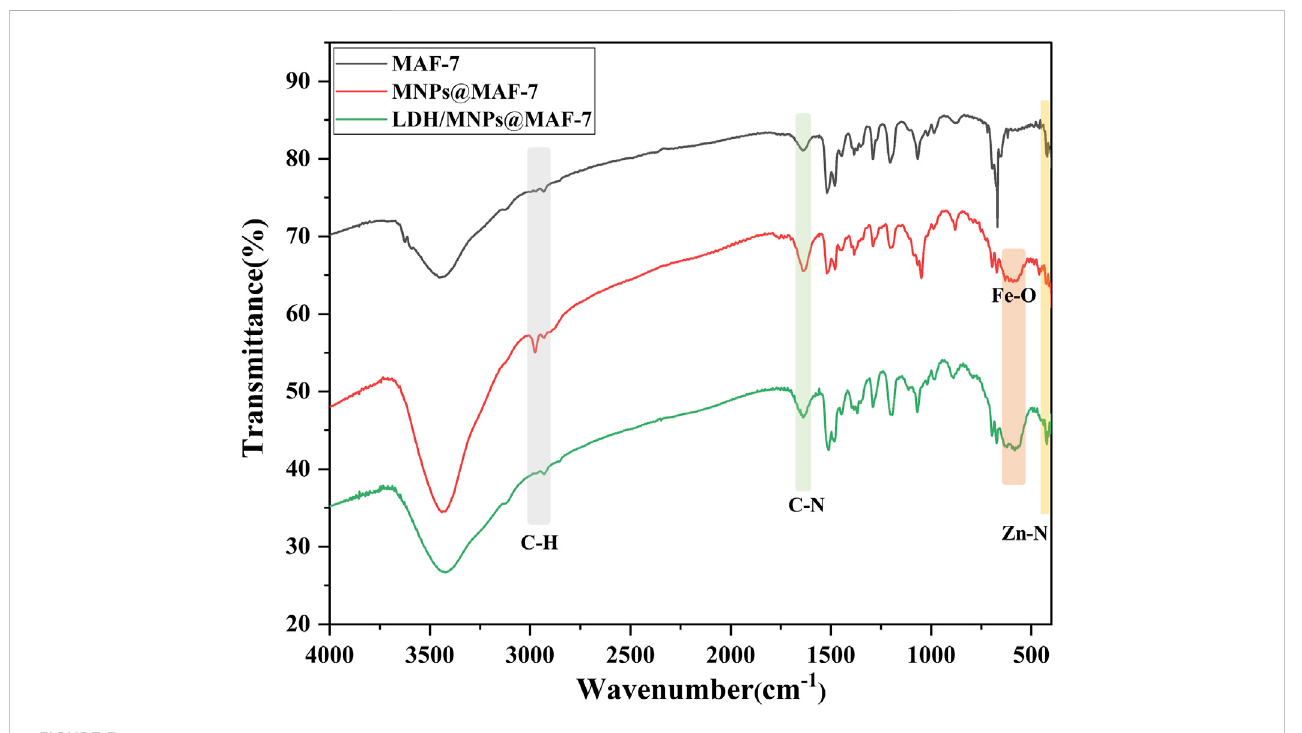
FIGURE 3 FT-IR spectra of MAF-7, MNPs@MAF-7, and LDH/MNPs@MAF-7.